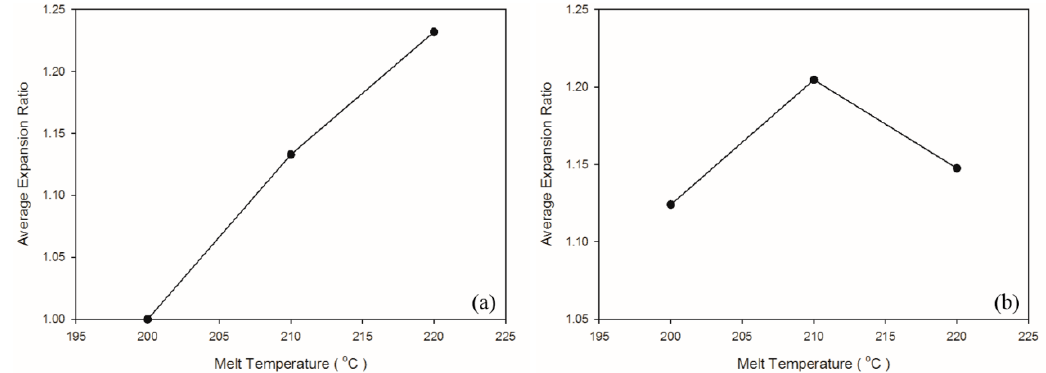
Figure 10. Expansion ratio at various melt temperatures: ( a ) PP matrix and AC CBA; ( b ) PS matrix and AC CBA.